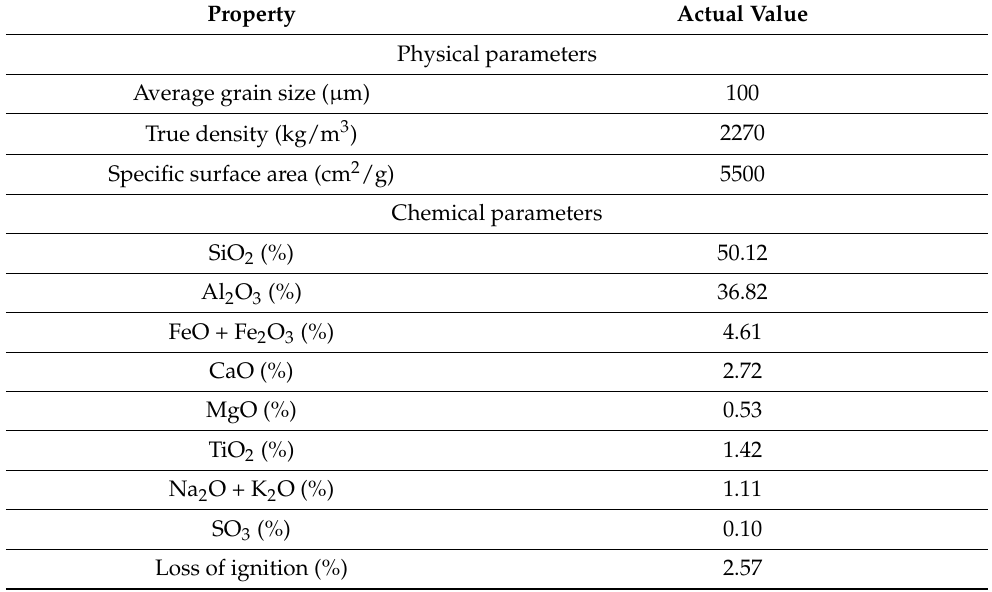
Table 2. Characteristics of